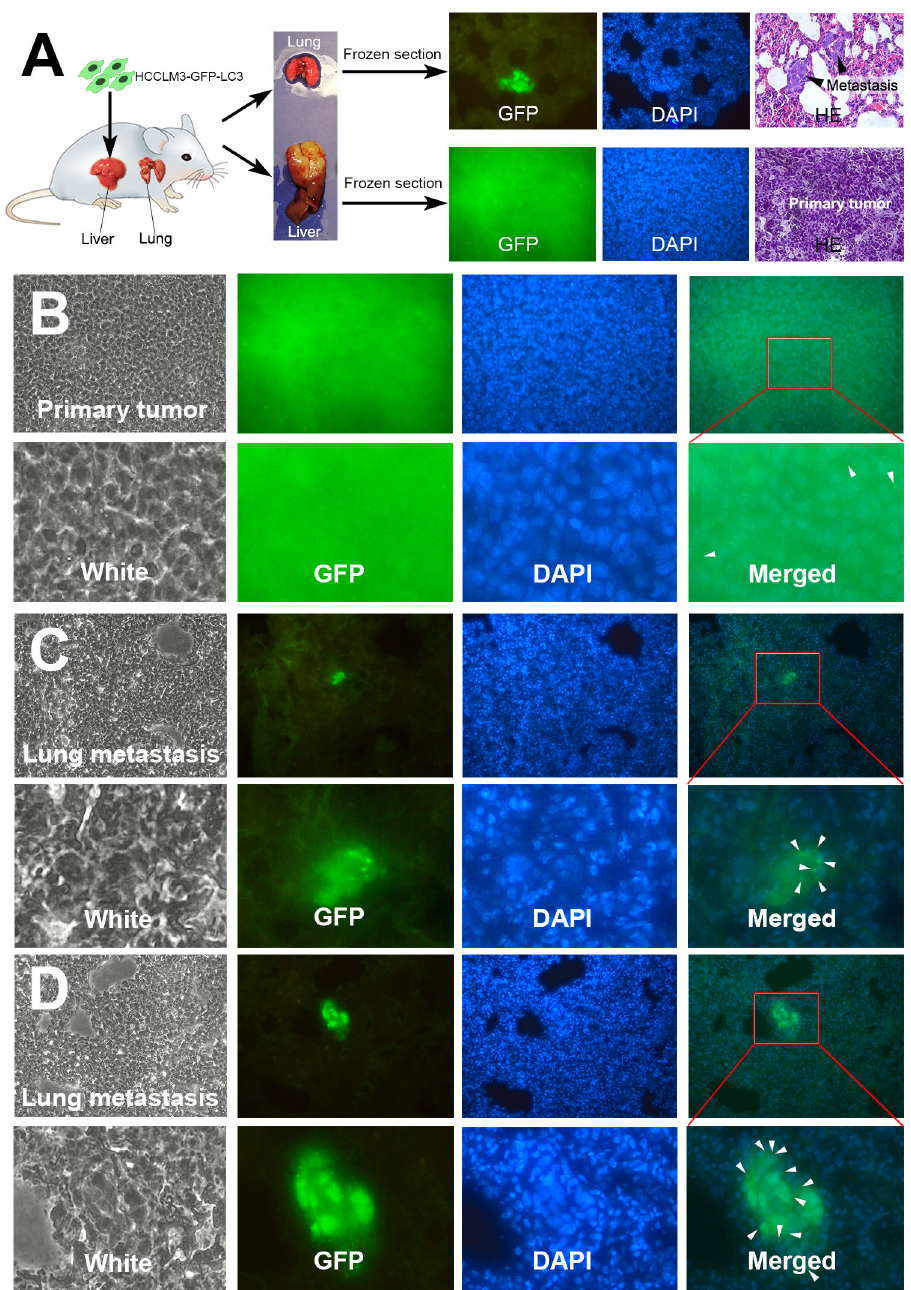
Figure 4. In vivo GFP-LC3 analysis revealed higher level of autophagy in metastatic colony as compared with primary tumor. (A) Establishment of mouse model of pulmonary metastasis using HCCLM3-GFP-LC3 cells and fluorescence microscopic analysis of GFP-LC3-expressing lung metastasis and primary tumor. (B) Primary HCC tumors showed low level of autophagy. (C, D) Pulmonary metastatic colonies displayed significantly higher level of autophagy than primary tumors. And early metastatic colonies (C) displayed higher autophagic activity than late-stage metastatic foci (D). Autophagy was quantified by measuring the number of GFP-LC3 dots / GFP-LC3-expressing area. White arrows indicate GFP-LC3 dots. doi: 10.1371/journal.pone.0074407.g004 immunohistochemistry and found that metastatic melanoma al [17-19] detected autophagy in melanoma through LC3 cells displayed high level of autophagy and the upregulated